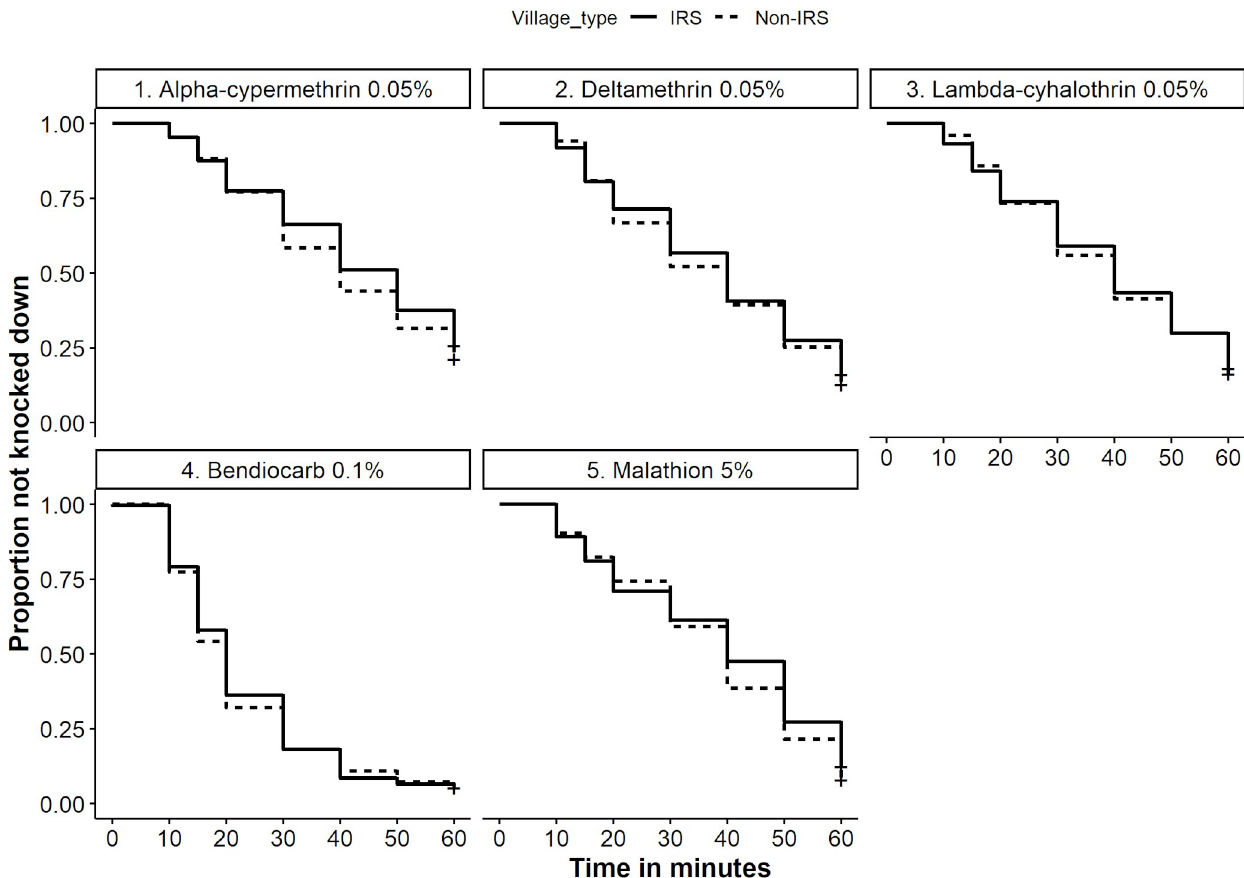
Fig 4. Time until knockdown of P . argentipes with different insecticides tested in Phase I in the IRS and the non-IRS villages.